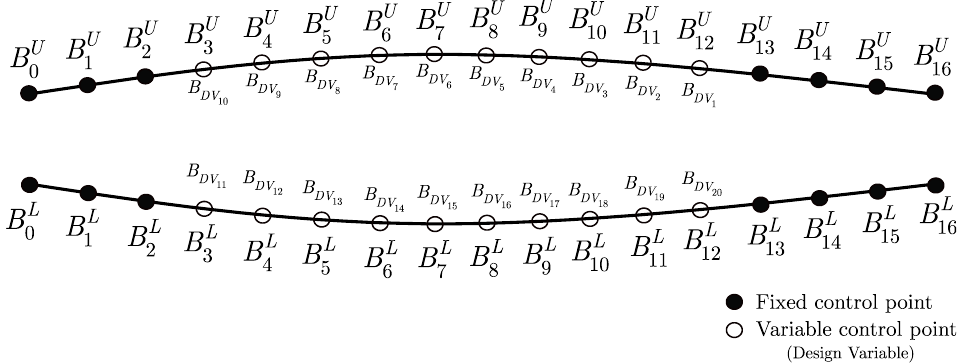
Figure 4. Definition of the design variables (variable control points). The coordinates of the Bezier control points were not real and were plotted this way for the sake of simplicity in the definition.